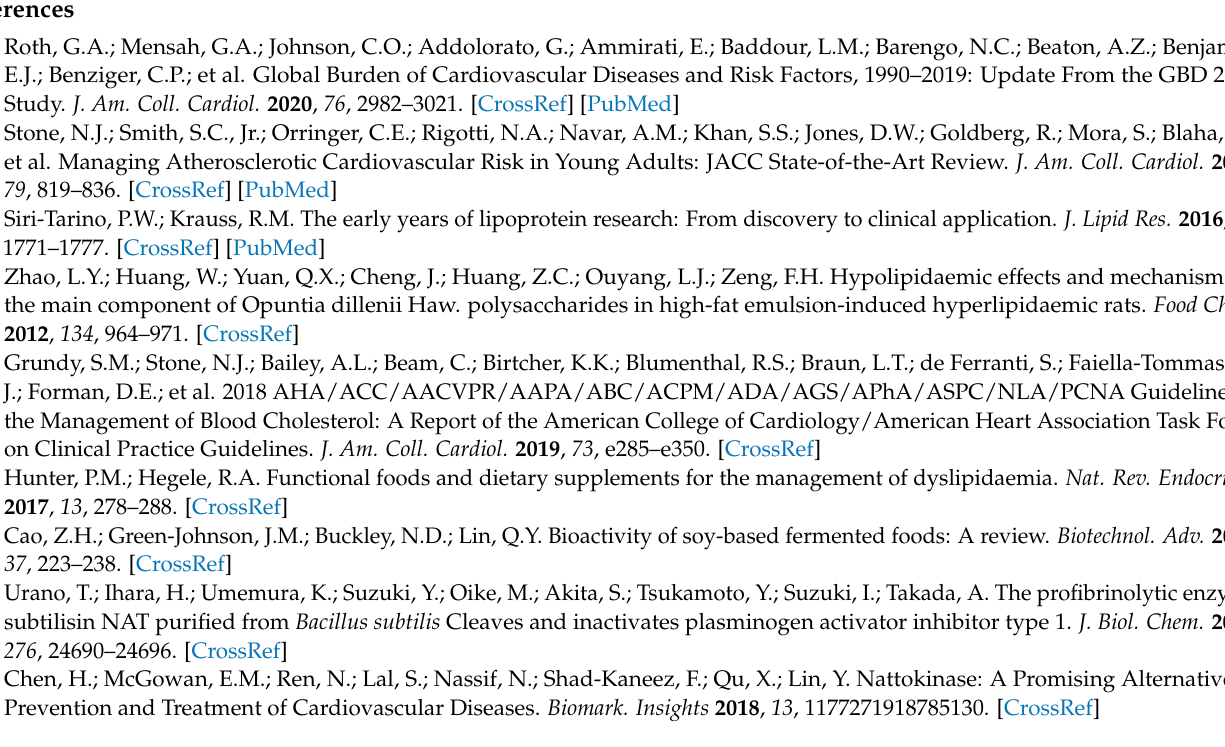
Supplementary Table S2: Relative abundance of gut microbiota at class, order, family and species levels in ApoE -/- mice fed with a CD or HFD, without or with NR at the end of the study; Supple- mentary Table S3: Fecal concentrations of short-chain fatty acids in ApoE -/- mice fed with a CD or HFD, without or with NR at the end of the study; Supplementary Table S4: Correlations between relative abundance of gut microbiota and blood biochemical parameters, Oil Red O staining of aorta and gene expression in cholesterol metabolism; Supplementary Table S5: Correlations between the relative abundance of gut microbiota and concentrations of short-chain fatty acids in